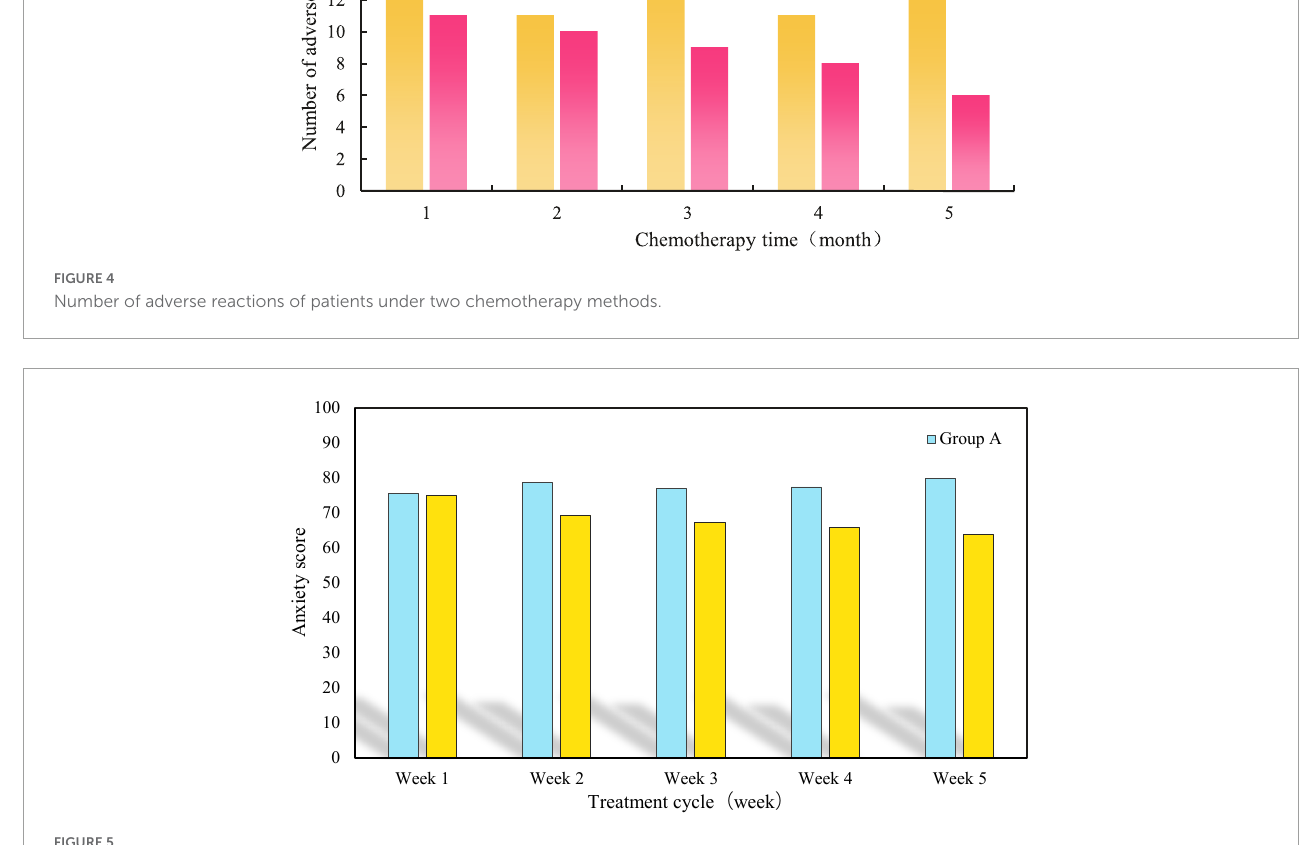
signals. Special diagnosis extraction includes melody speed, rhythm, frequency, length of time, melody, timbre, lyrics features,